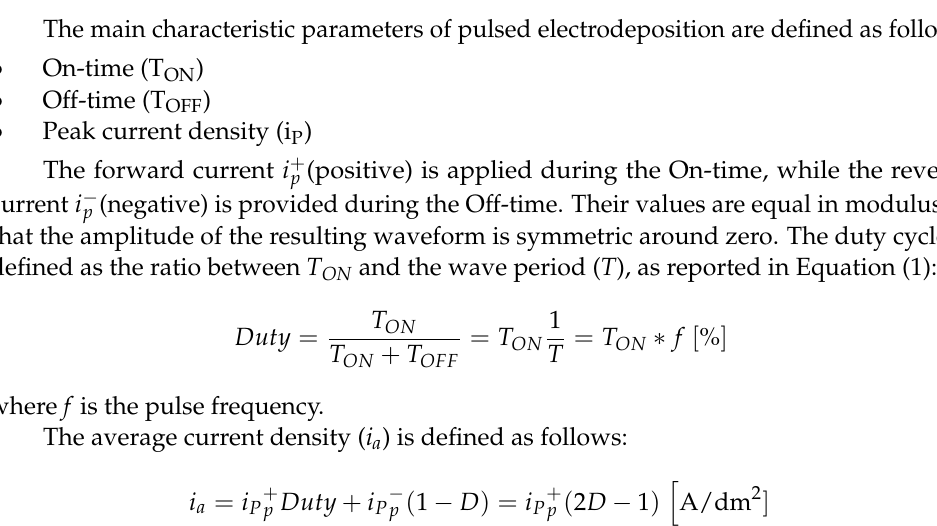
Figure 2. Schematic of the thermal measurement system.